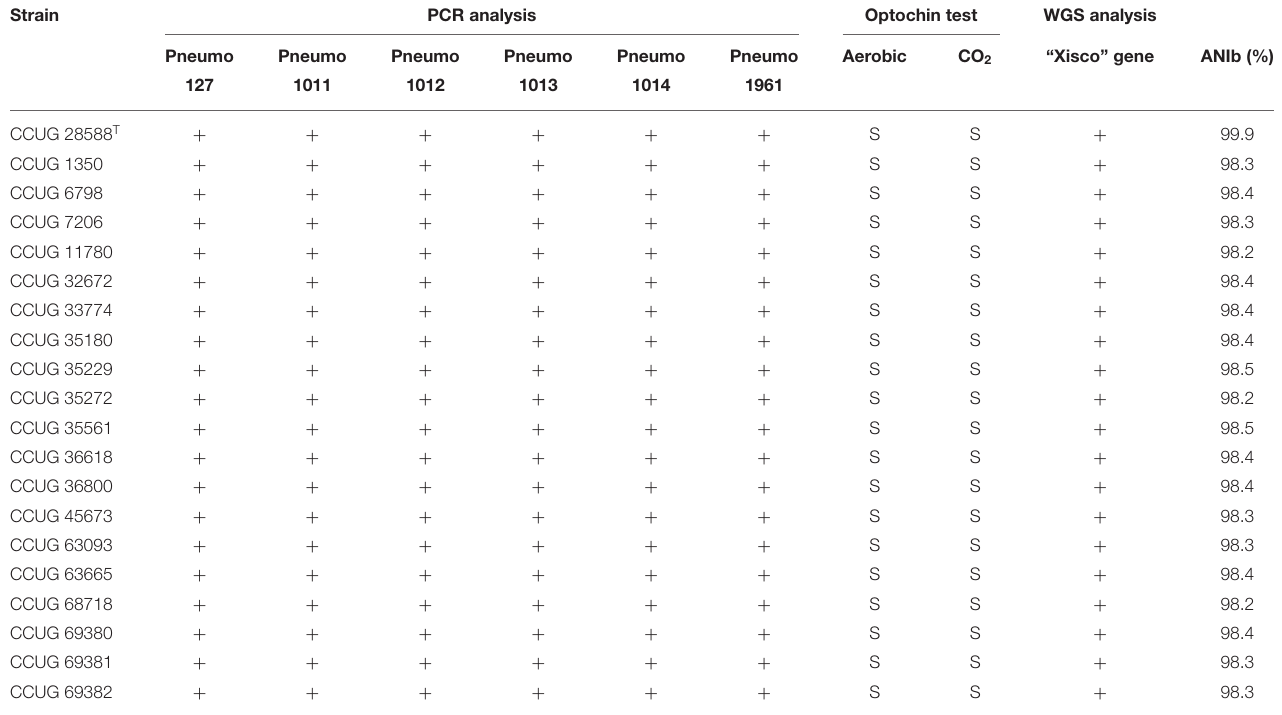
TABLE 4 | Genotypic and phenotypic characterization of S. pneumoniae strains used for confirmation of gene markers.